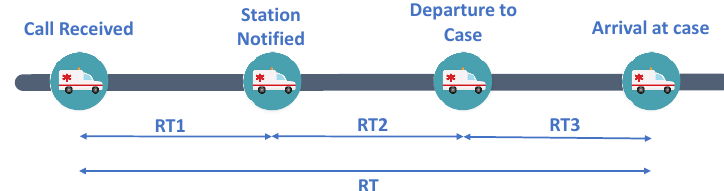
Fig. 3. Response Time